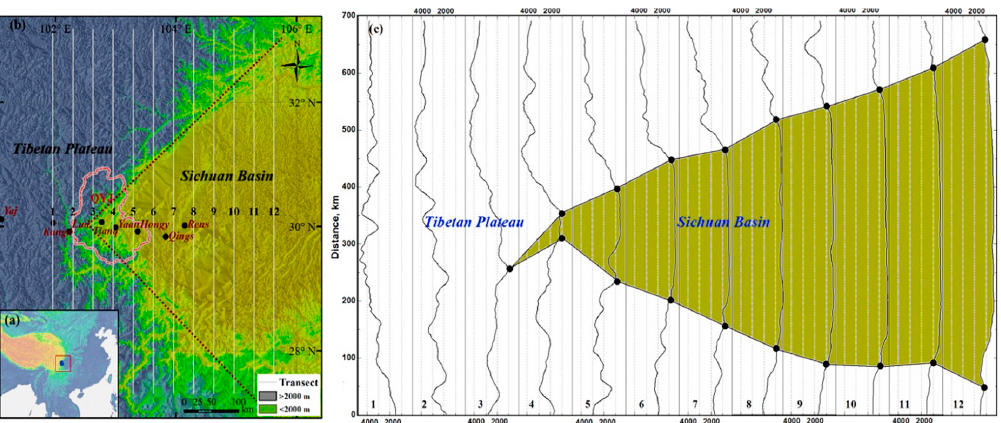
Figure 2. The location ( a ) and geomorphology ( b ) of the transition area from the Sichuan Basin to the east TP. The Sichuan Basin is embedded in the horn-mouth geomorphology of the eastern TP margin. The 12 columns in ( c ) correspond with the parallel transects in (b), and show the elevation profiles (unit: m) of these transects. The shade areas in (c) denote the west part of the Sichuan Basin.